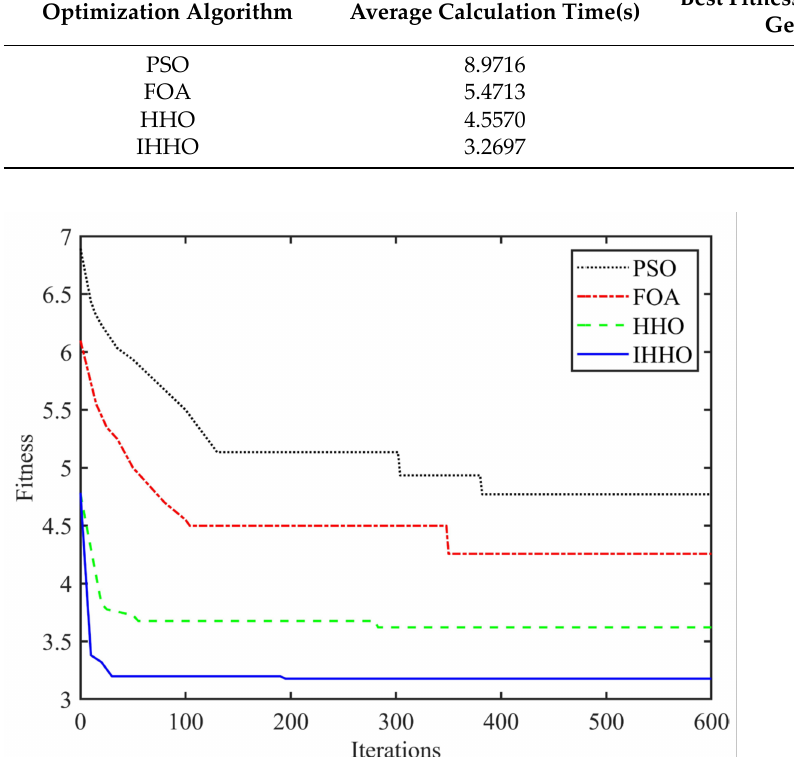
Figure 8. Iterative process of four optimization algorithms.